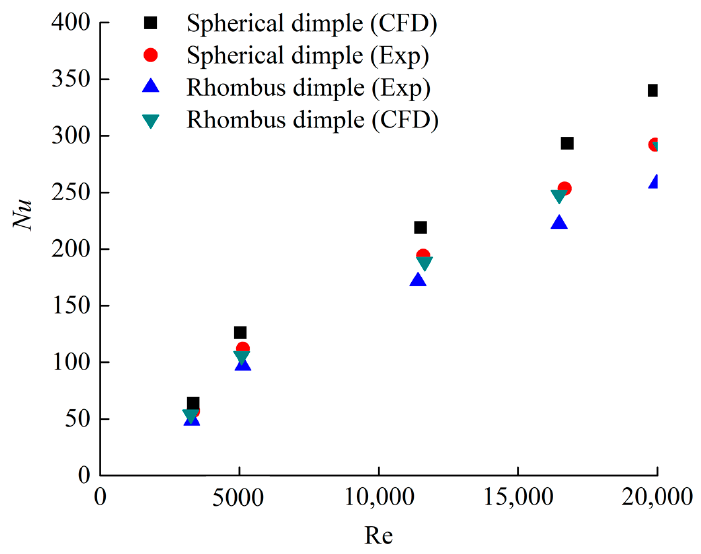
Figure 10. Nusselt numbers of the dimpled channels.